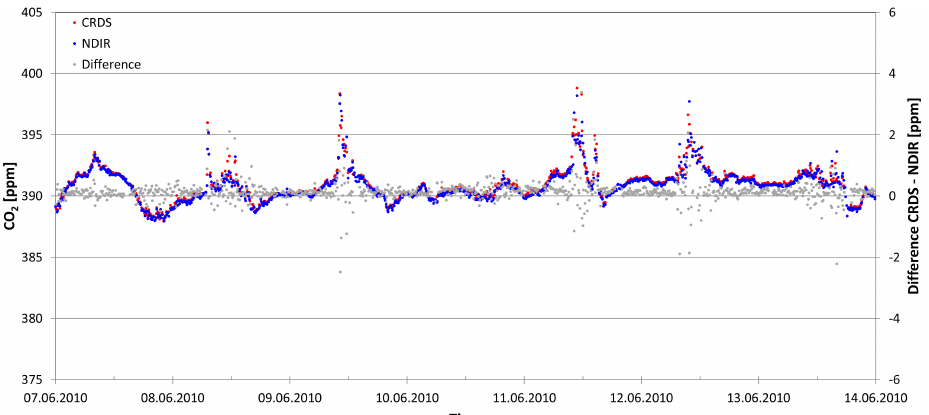
Figure 4. Time series of 115s averaged CO 2 mole fractions measured with CRDS (red) and NDIR (blue) at JFJ (left-hand y axis scale) and the difference between the two systems against time (grey points) (right-hand y axis scale) for 1 week in June 2010.